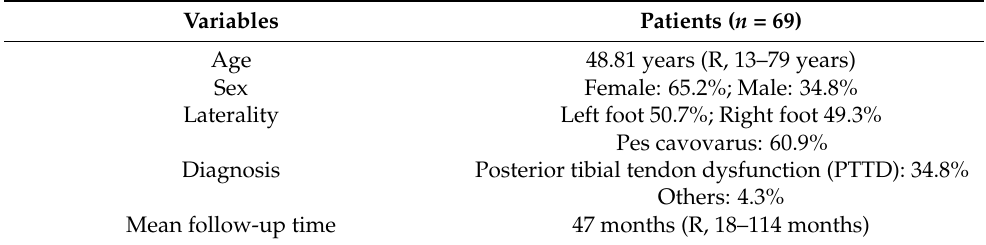
Table 1. Case demographics and distribution.